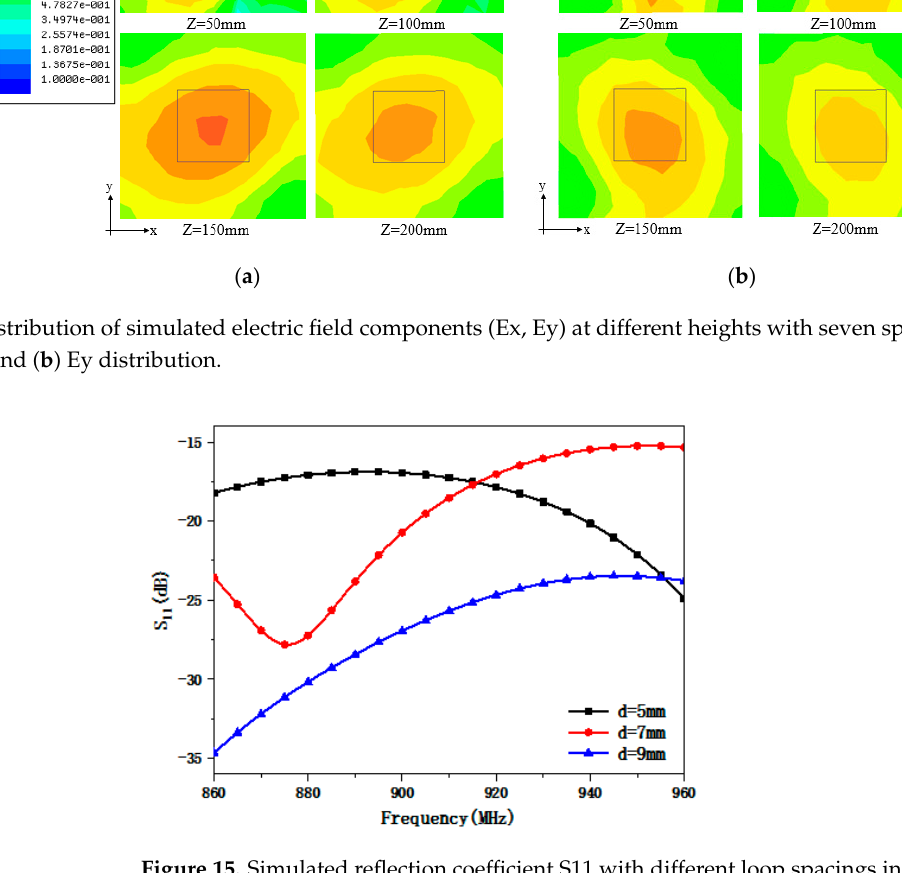
Figure 14. Distribution of simulated electric field components (Ex, Ey) at different heights with seven spiral loops: ( a ) Ex distribution and ( b ) Ey distribution.